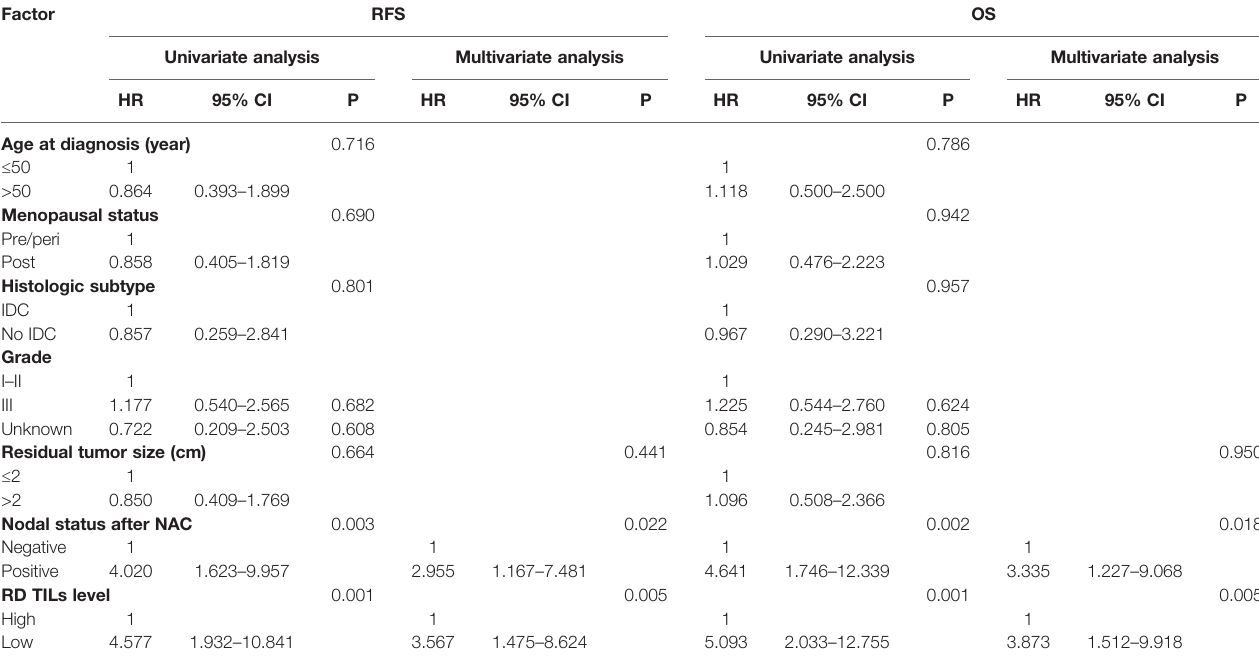
TABLE 5 | Univariate and multivariate analyses for RFS and OS in Ki67 no decrease group.